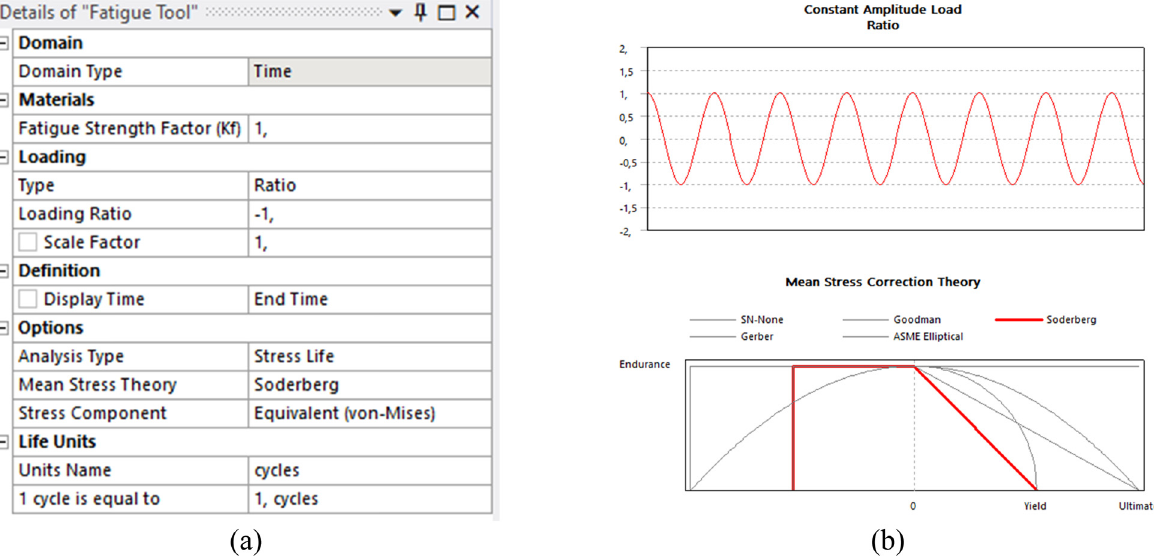
Figure 7: Fatigue settings for the ANSYS simulation: ( a ) con fi guration in fatigue tool, and ( b ) assumed load ratio and mean